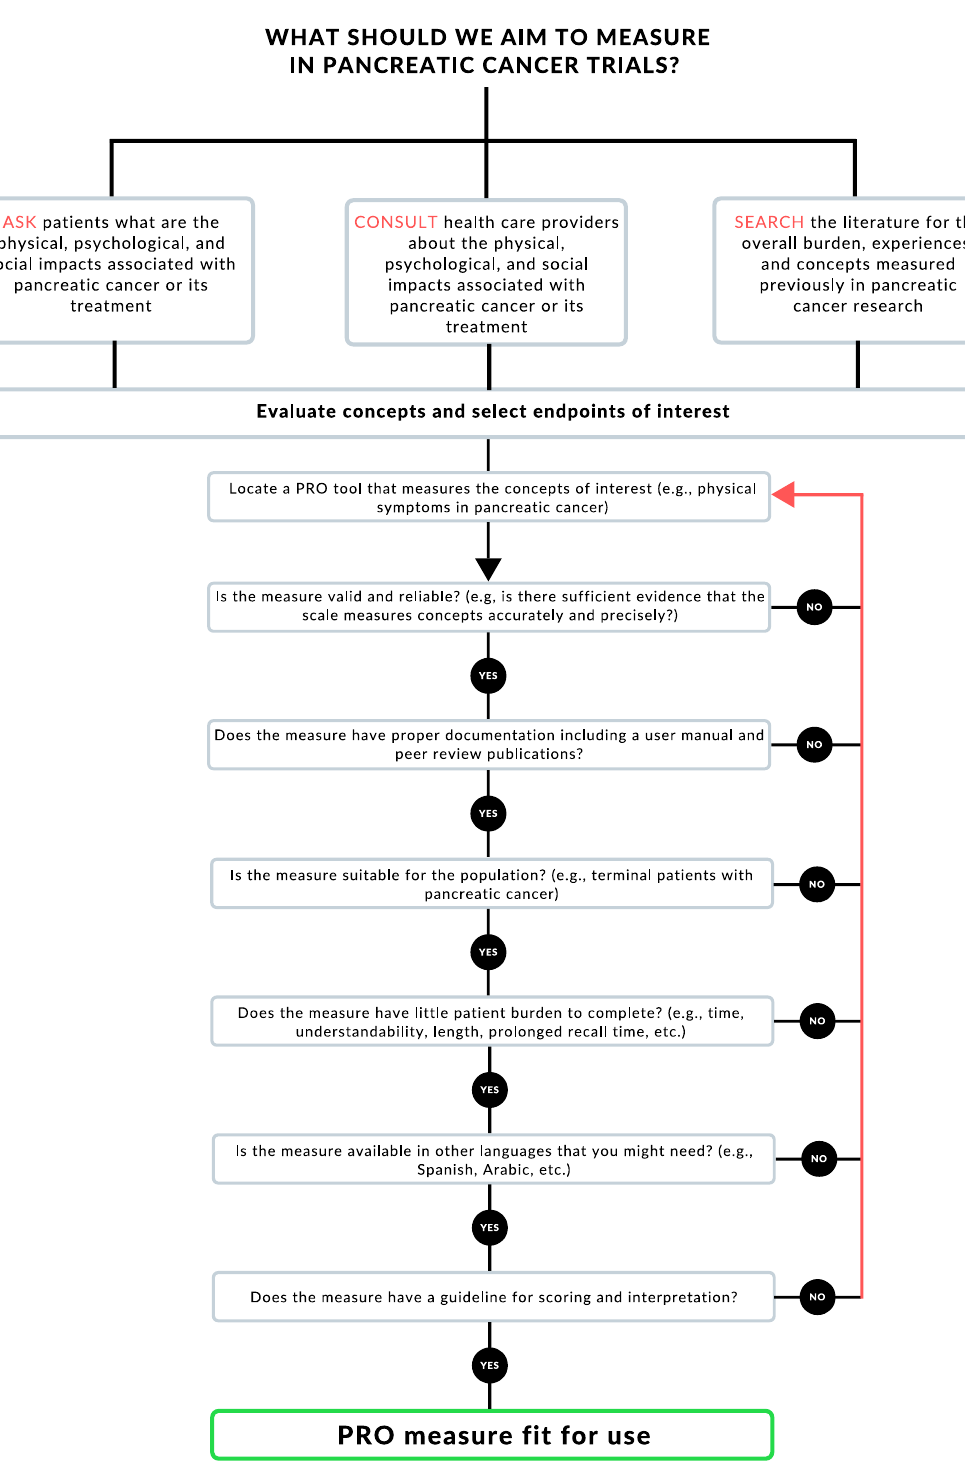
Figure 1. Patient-reported outcome (PRO) measure selection